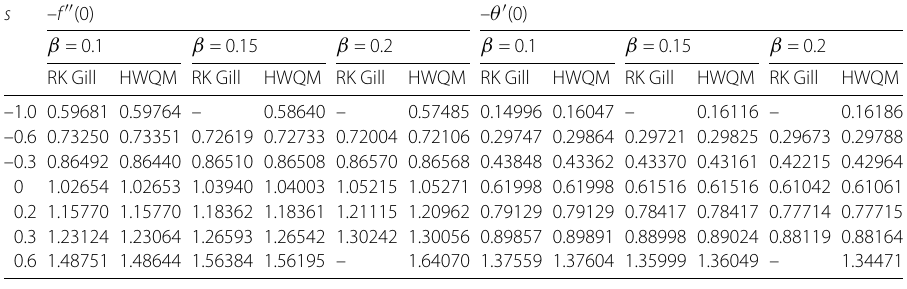
Figure 1 The velocity profile for different values of β when Pr = 1, γ = 0.5, and s = 0